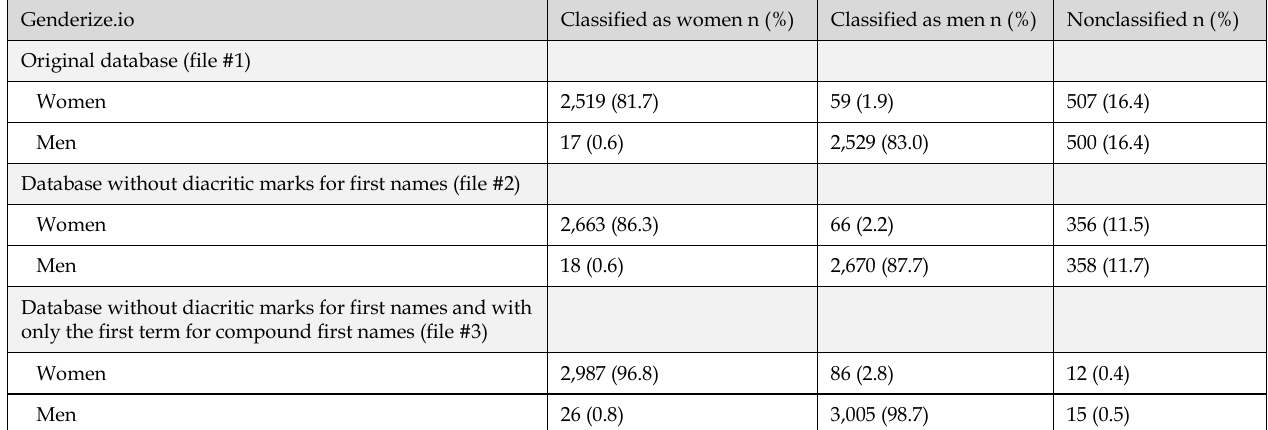
Table 1 Confusion matrices for genderize.io (n=6,131 physicians) Genderize.io